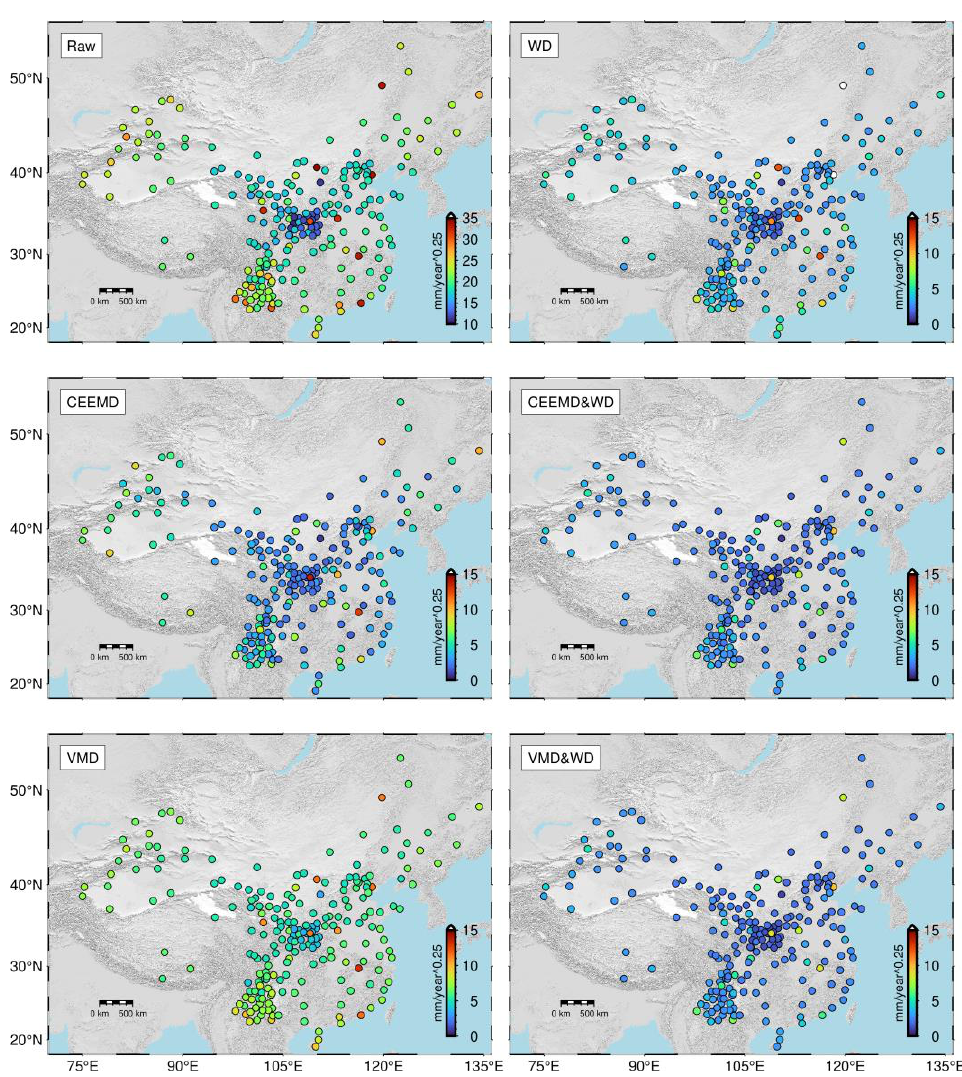
Figure 5. The estimations of flicker noise of GPS vertical coordinate time series with six strategies for the 226 CMONOC stations employed in this study.